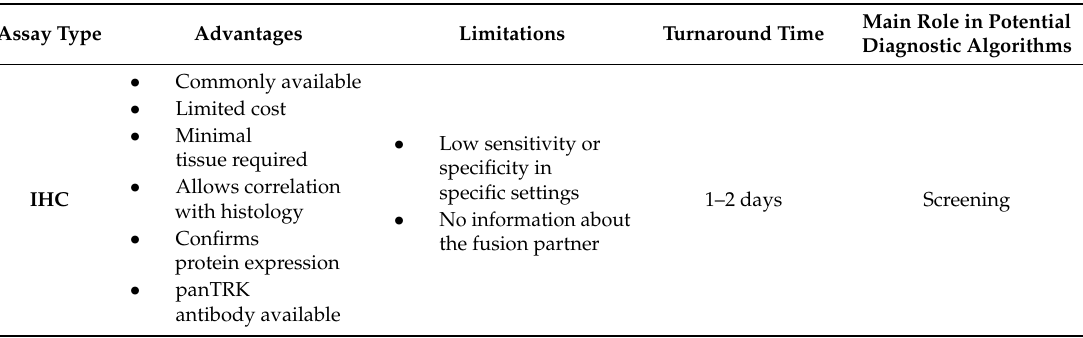
Table 3. Available diagnostic assays for detecting NTRK